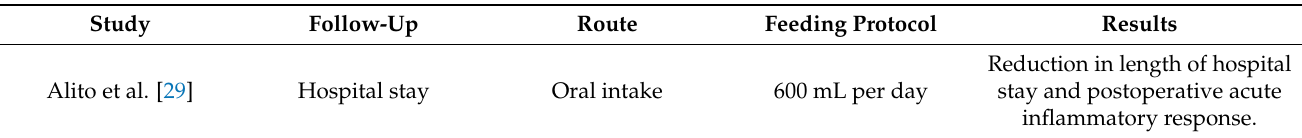
Table 7. Elective orthopedic study rates and